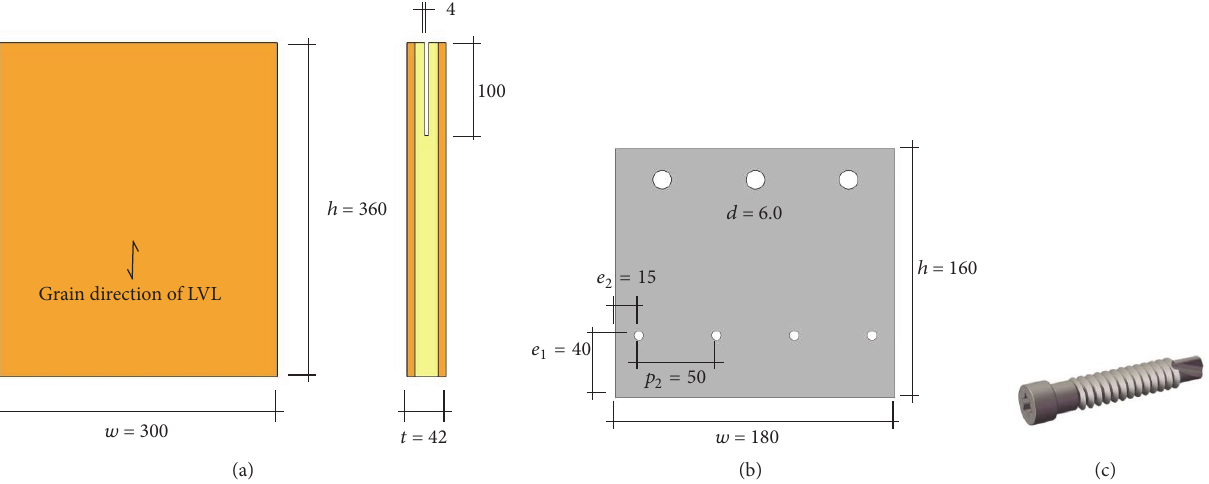
Figure 4: (a) The PlyBoard specimen, 300×360×42 mm; grain orientation was vertical in the uplift tests and horizontal in the shear tests; (b) the steel connection plate, 180×160×3 mm, quality S355, with hole pattern for the four-fastener configuration; the two-fastener configuration had only the corner holes and the single configuration (used in the uplift tests) had a centre hole; (c) the Adjufix frame screw, self-drilling, size 6.7 × 42 mm, 𝑑 = 6.7 mm, 𝑑 = 5.8 mm. Note that the notation in figure (b) corresponds to the notations in (5a), (5b), and (6a) and nom eff is valid for the uplift tests. For the shear tests this is changed so that 𝑒 1 = 15mm and 𝑒 2 = 40